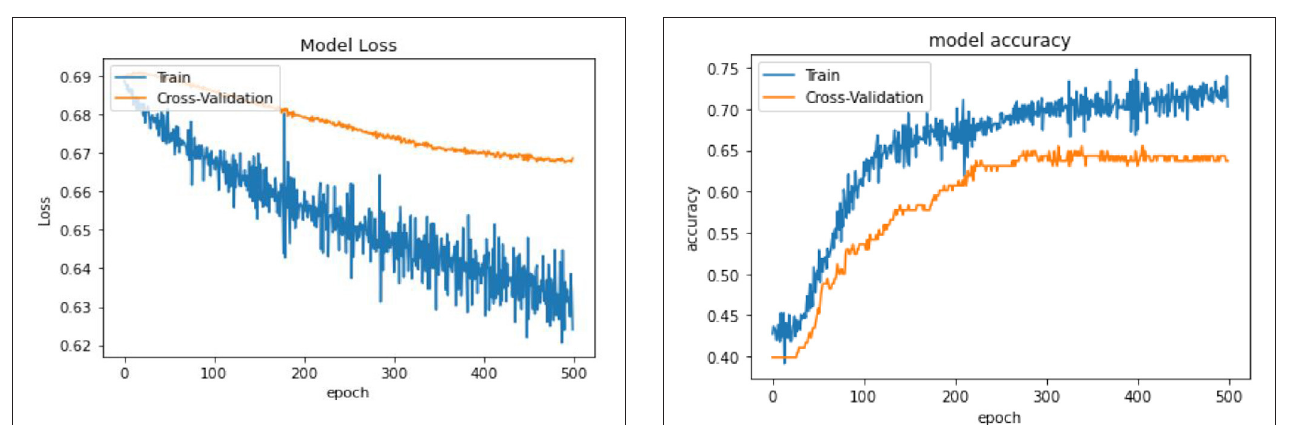
FIGURE 12 | ANN model accuracy-India.